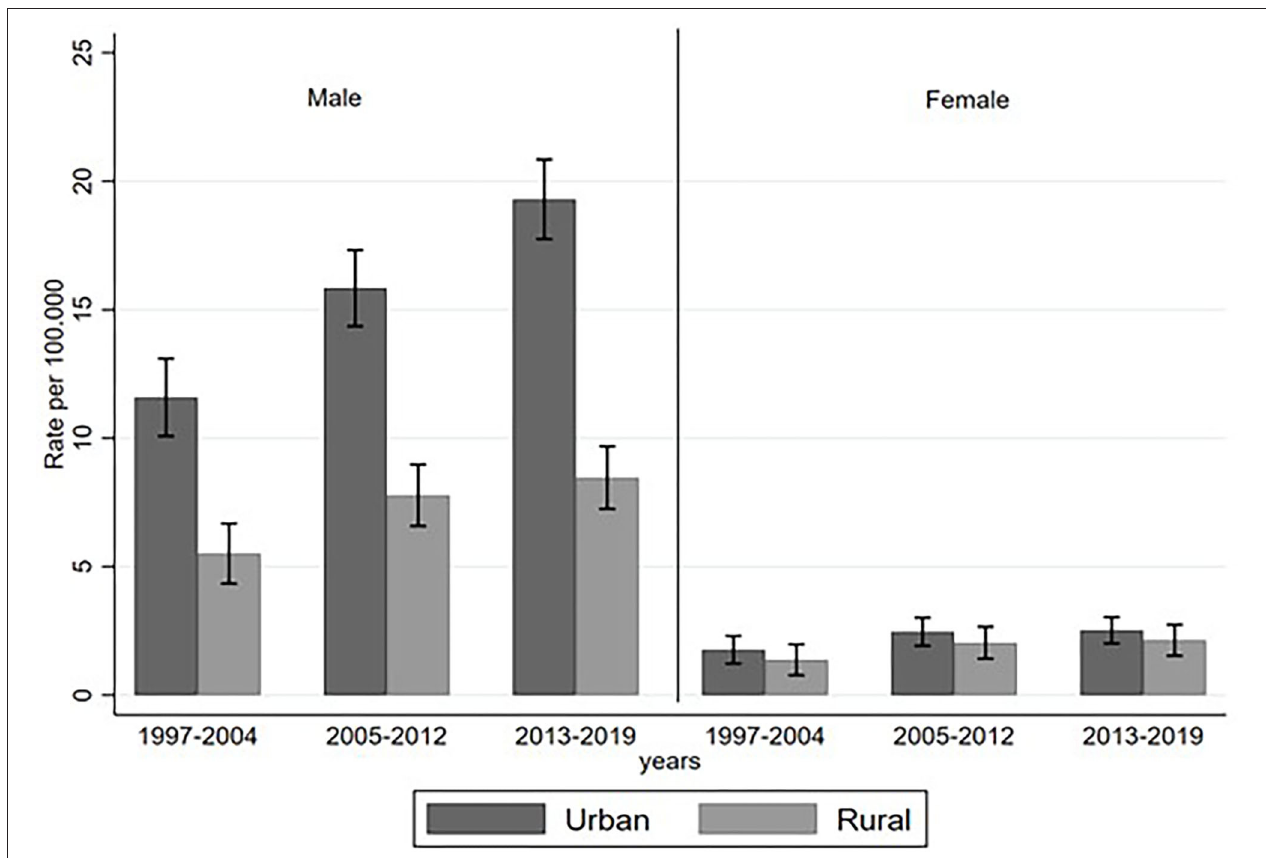
FIGURE 2 | Suicide rates by sex and area type among over 60-year-olds in Ecuador, 1997–2019.